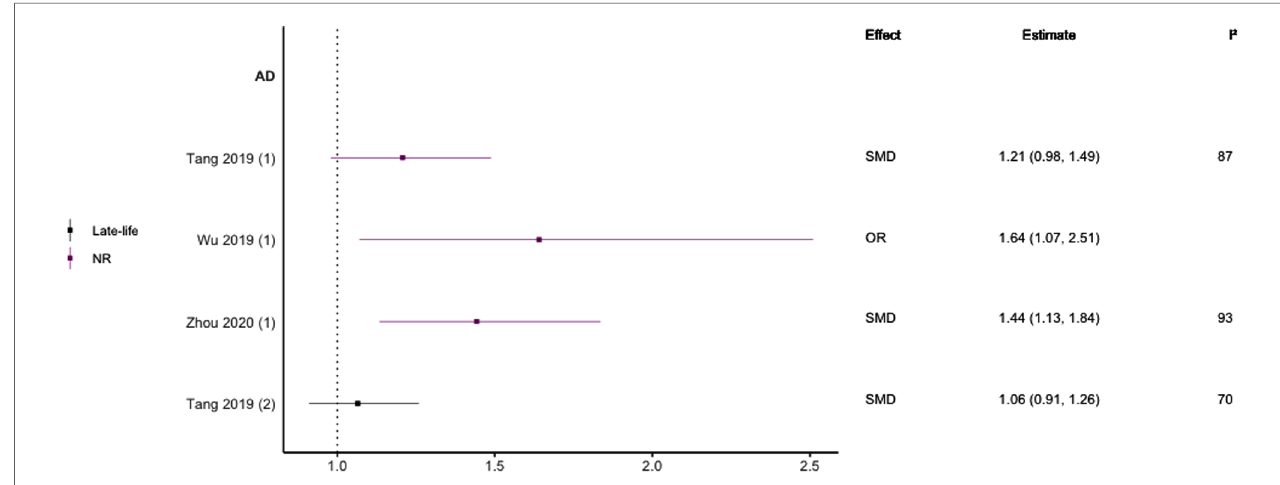
FIGURE 8 Effect estimates of meta-analyses reporting an association between LDL-C and AD. The vertical line represents no effect, with different colours conveying age strati fi cation. Note, SMDs have been converted to approximate ORs using OR ¼ exp